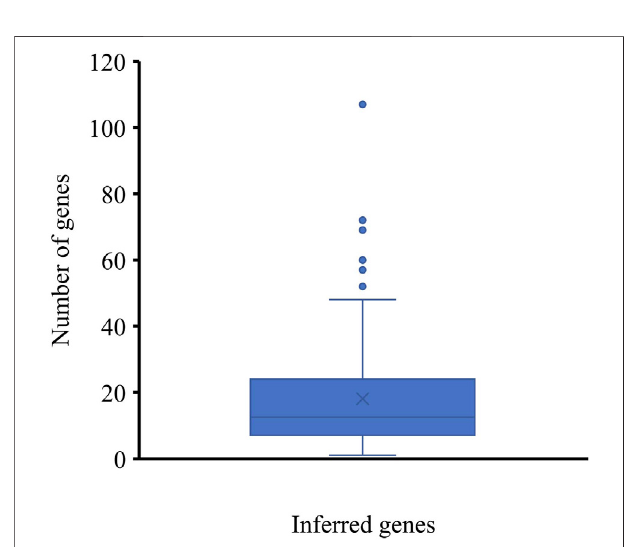
FIGURE 2 | Box plot of the number of interacting lymphoma-associated genes with high con fi dence scores of inferred genes. Several genes can interact with over twenty lymphoma-associated genes with high con fi dence scores ( ≥ 900), indicating the strong associations between inferred genes with lymphoma-associated